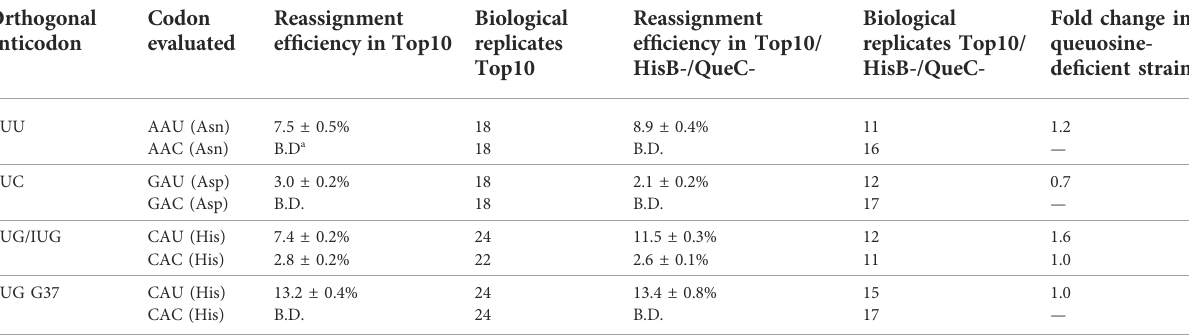
TABLE 1 Sense codon reassignment ef fi ciency (SCR) by variants of the M. jannaschii orthogonal translation machinery with AUN anticodons in queuosine-containing and queuosine-de fi cient E. coli . Orthogonal